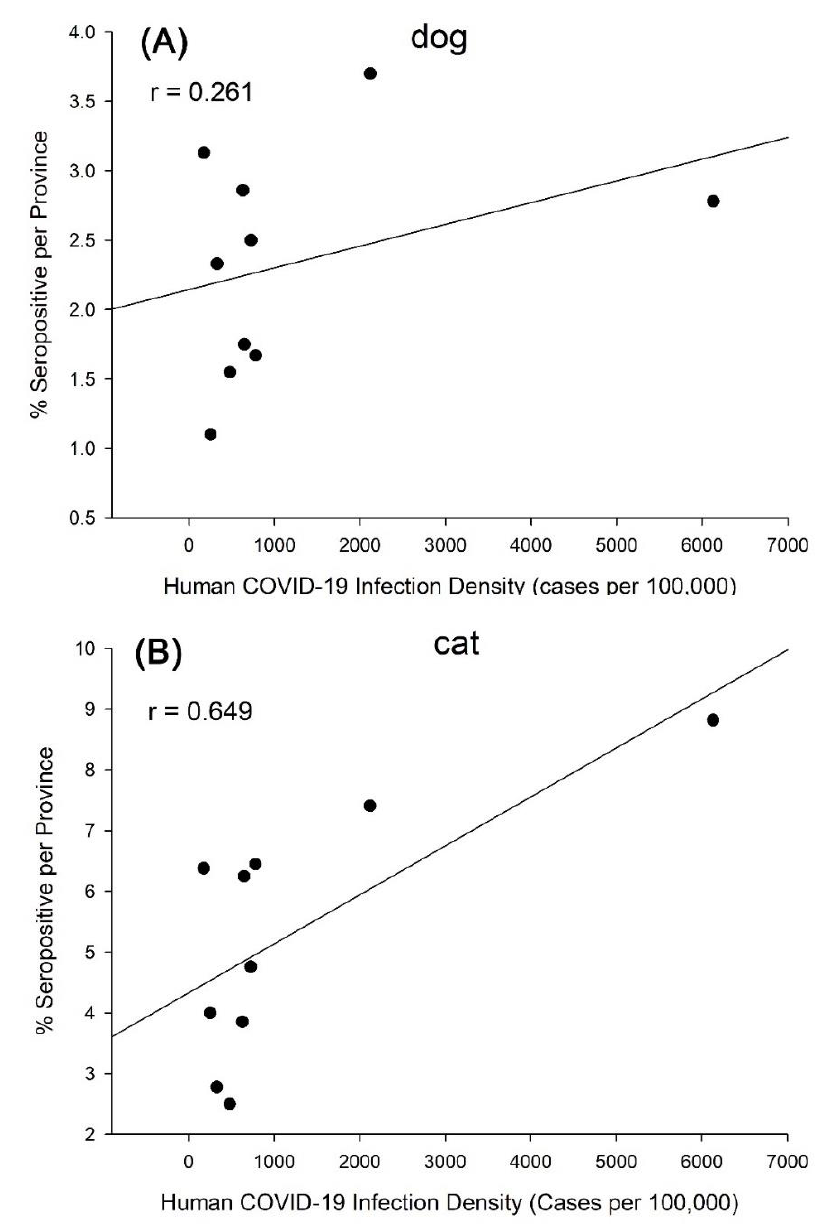
Figure 2. Correlation of percentage of seropositive dogs ( A ) and cats ( B ) per province and human COVID-19 infection in